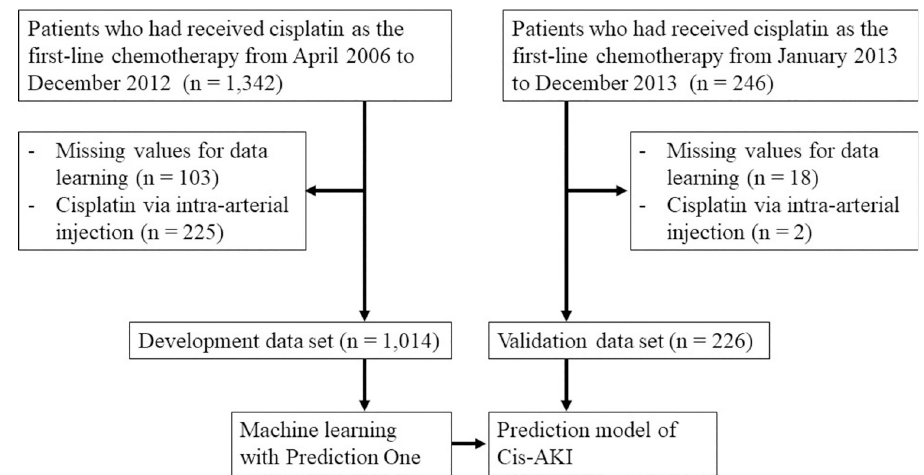
Fig 1. Study protocol. Cis-AKI: Cisplatin-induced acute kidney injury.